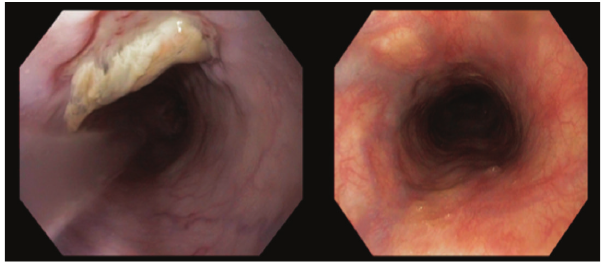
Figure 4: One month and four months after IR recannulization and stenting SVC with resolution of